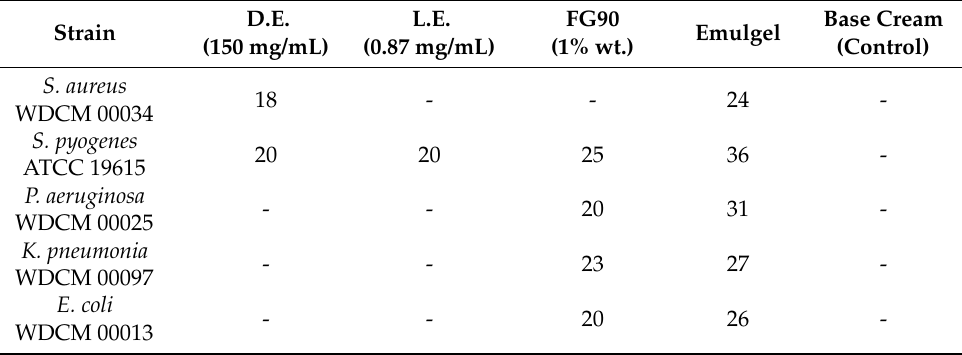
Table 4. Comparison of the inhibition halos obtained from the raw materials and the